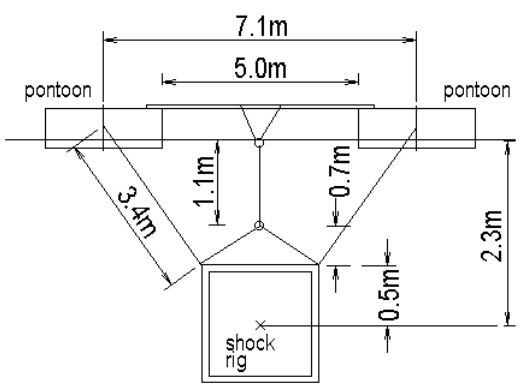
Fig. 1. Schematic drawing showing the chain arrangement used to secure the shock rig with respect to the pontoons. The charge is located at 2.3 m depth, perpendicular to the test plate